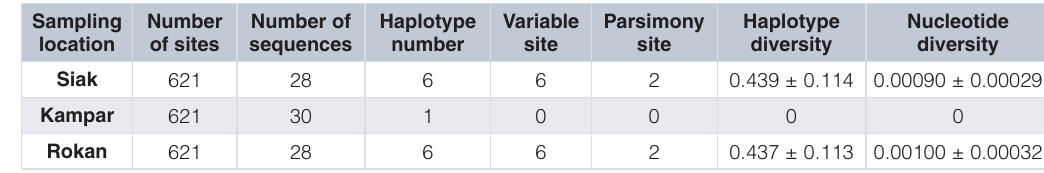
Table 3. Nucleotide variation in mtDNA CO1 of Osteochilus melanopleurus by DnaSP5.